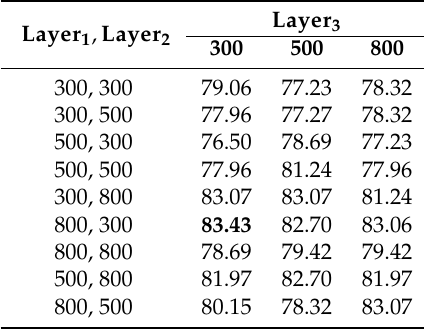
Table 7. Average classification accuracy results for an RBM with three hidden layers using the AAhydro